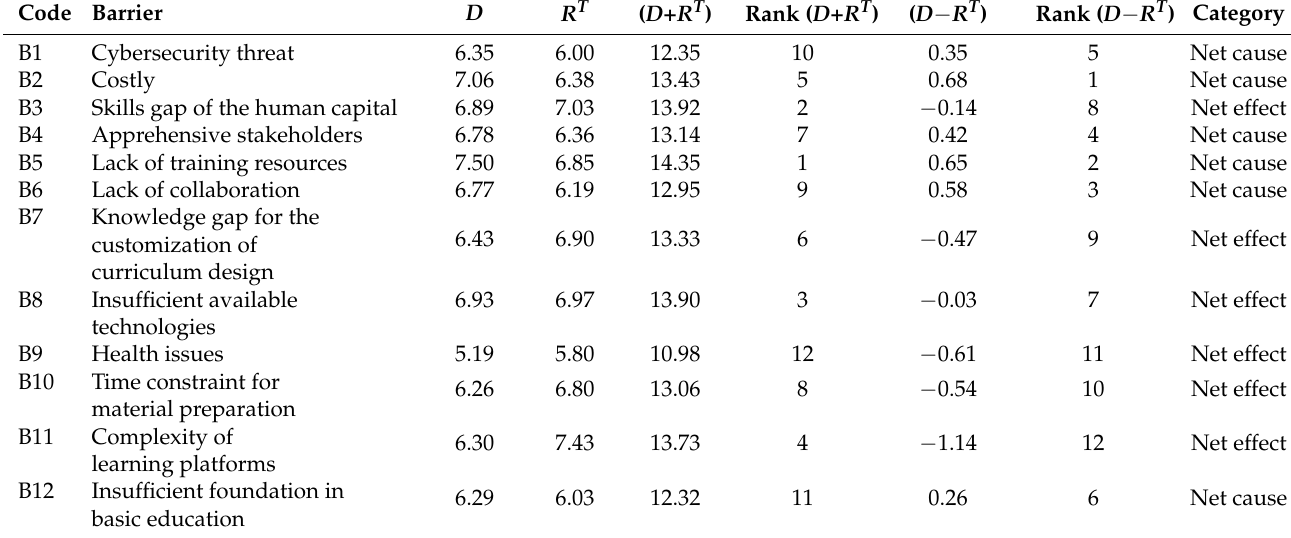
Table 2. The prominence and relation vectors.